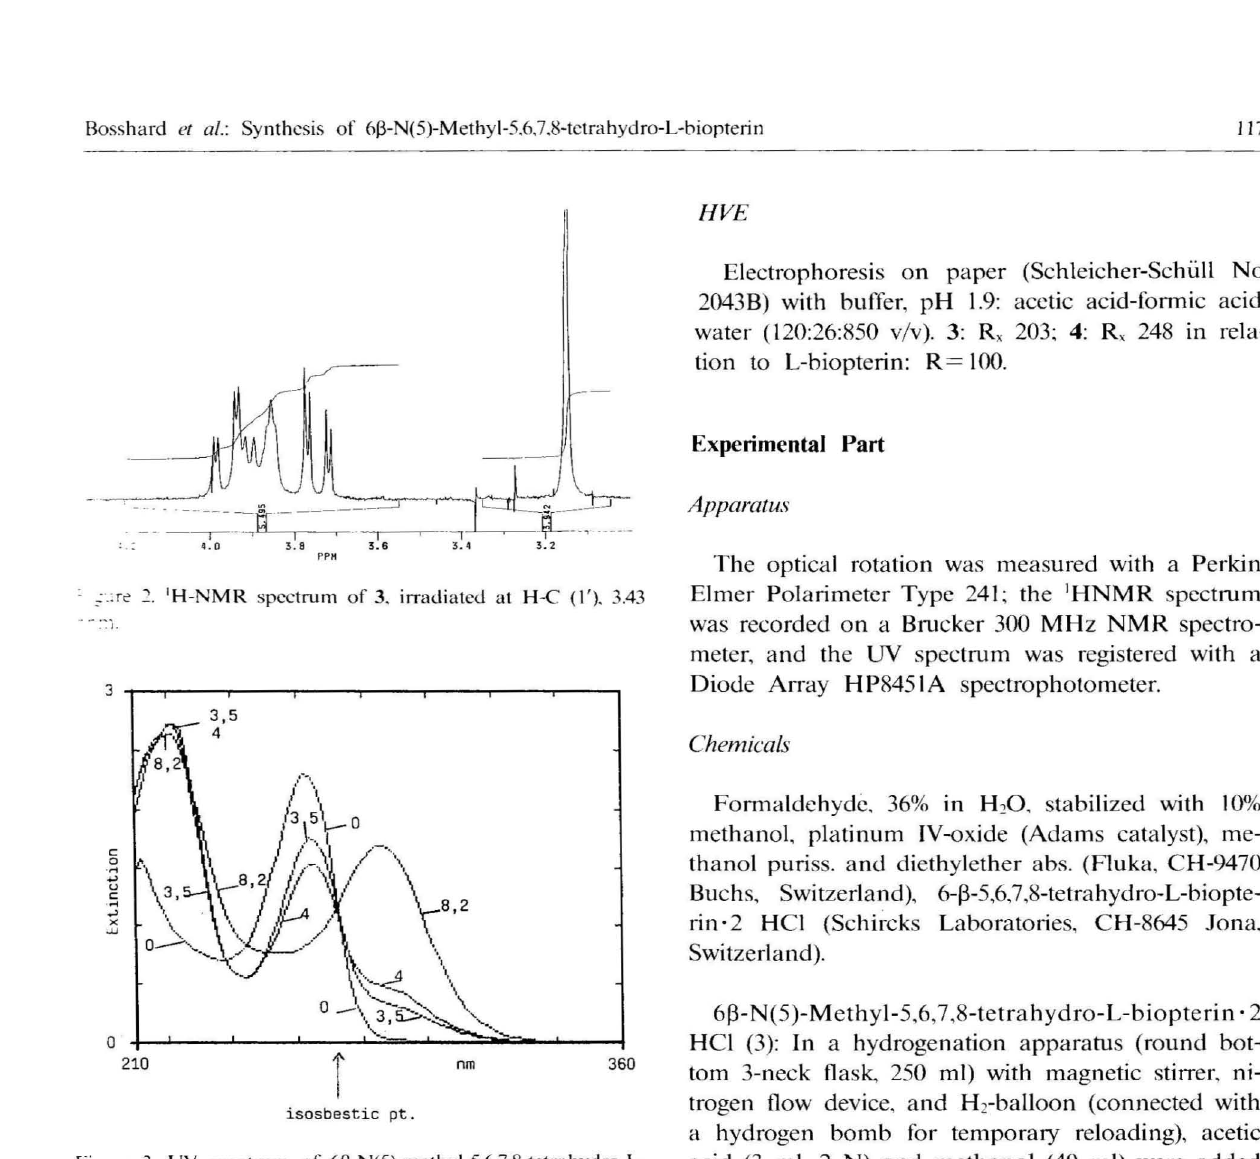
Figure 3. UV spectrum of 6f3-N(S)-mcthyl-S.6,7.8-tetrahydro-L biopterin 2 HC\. Curve numher represents pH of solution (C=SO mg